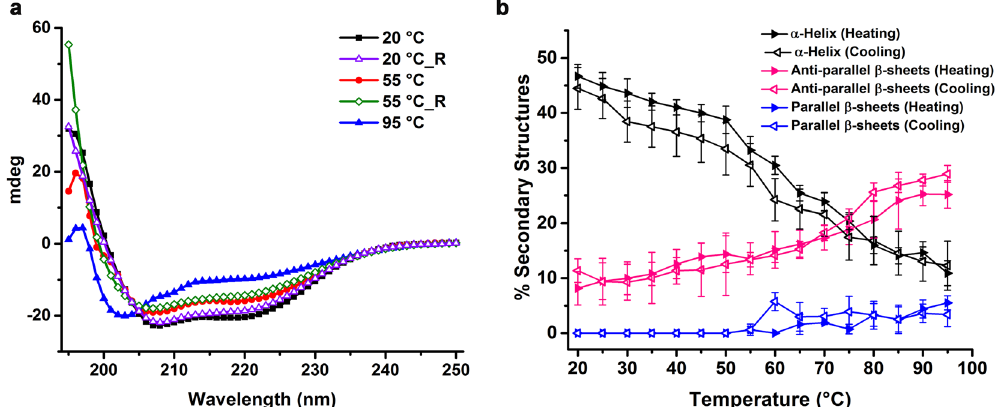
Figure 4. CarD undergoes reversible thermal folding in solution. ( a ) CD spectra obtained during thermal denaturation of CarD (10 μ M). CarD was heated from 20 to 95 °C and then cooled from 95 to 20 °C. For clarity, only the representative CD spectra acquired at 20 °C, 55 °C and 95 °C during both heating and cooling (labeled with ‘_R’) have been plotted. The CD spectra reveal partial unfolding at elevated temperatures and refolding upon cooling with the presence of isobestic/isodichroic point at 205 nm. ( b ) The plot showing variations in secondary structural content of CarD with change in temperature. With the increase in temperature, the percentage of α -helices decreases and the percentage of anti-parallel β -sheets increases